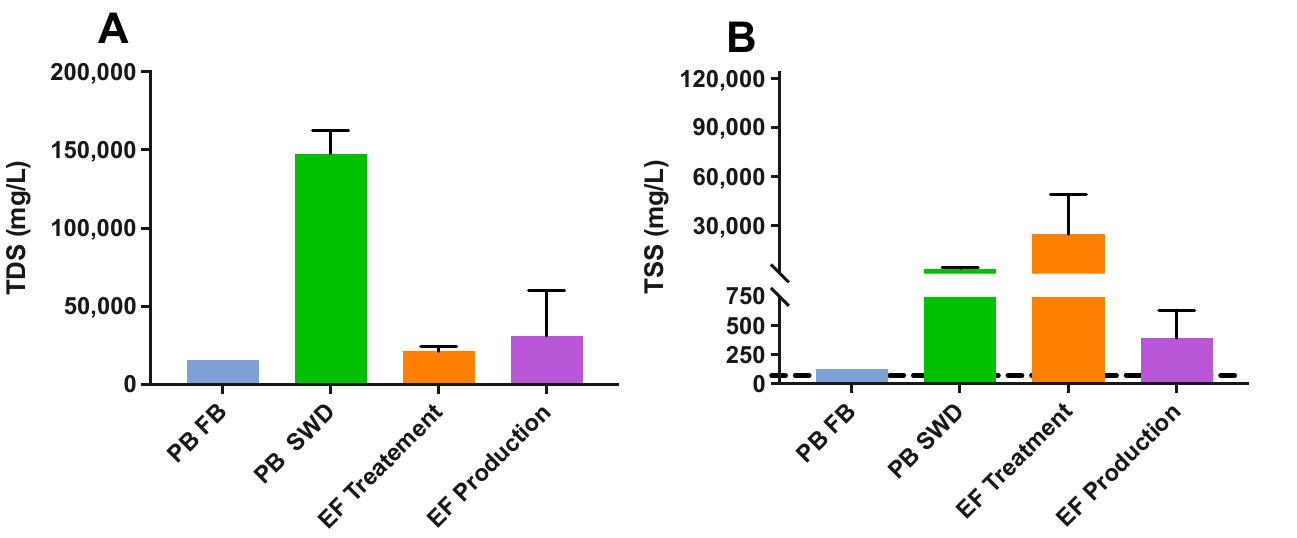
Figure 2. The collective ( A ) TDS and ( B ) TSS of the samples from different regions. The mean values are graphed with error bars illustrating standard error of the mean. The dashed lines represent recommended water quality guidelines for the reuse of PW for production well stimulation, as authored by Hildenbrand, King, Oetjen, and Liden et al. [5,27–29]. A viable alkalinity threshold (carbonate + bicarbonate) to determine whether or not PW is suitable for reuse is considered to be 300 mg/L (Table 1). Alkalinity not only influences